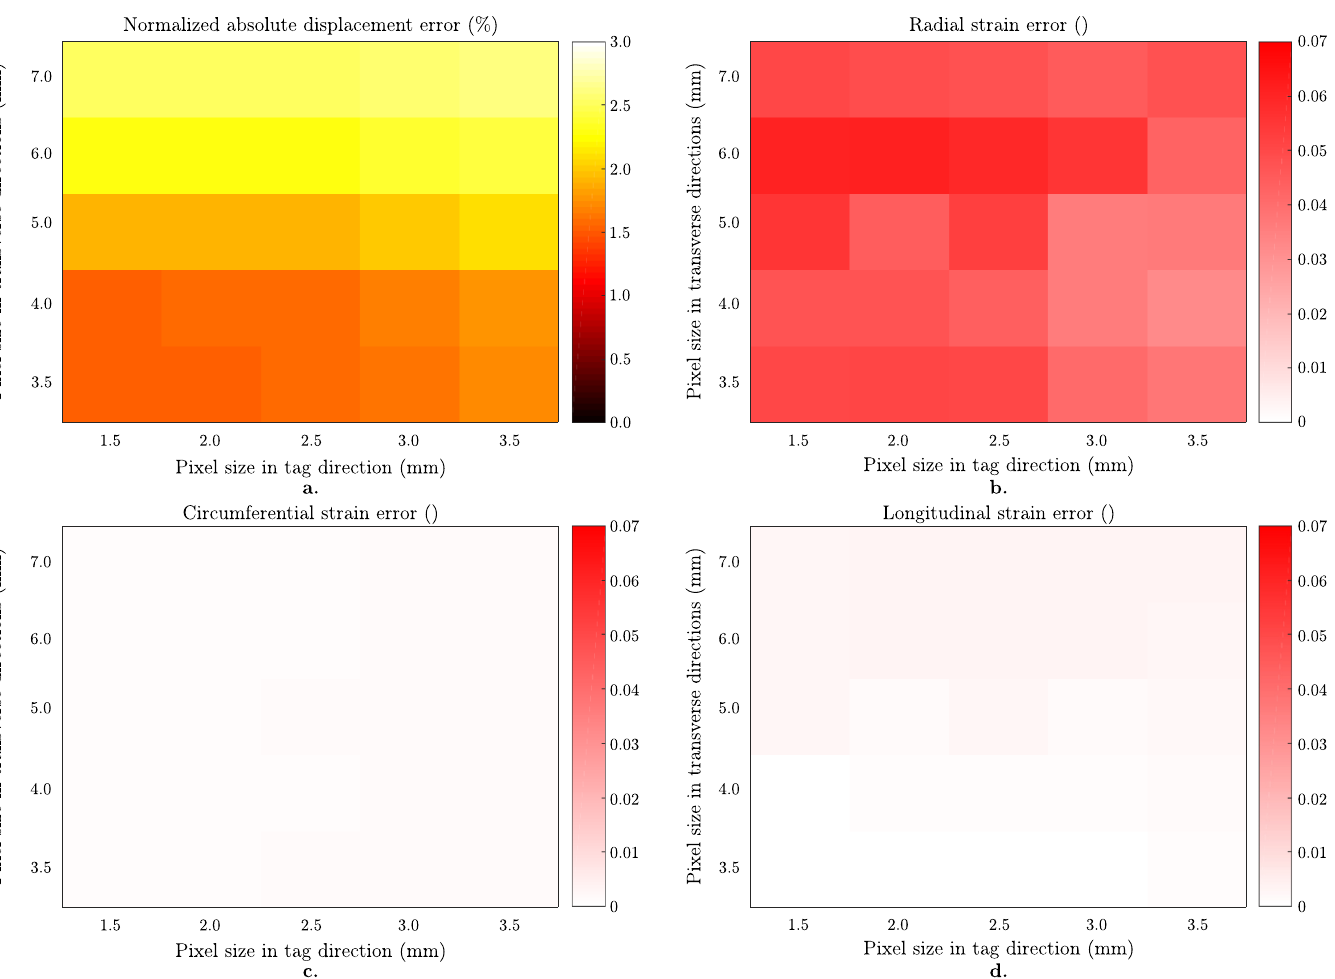
Fig 7. Effect of image resolution on anisotropically resolved image analysis. Results on noiseless images with 7 mm tag distance. Normalized mean ± standard deviations in displacement error norm (%) as a function of pixel size (a). Signed averages in Green-Lagrange strain component errors as a function of pixel size (b-d). Radial strain component is the most sensitive to an increase in pixel size (b), while circumferential (c) and the longitudinal (d) components are not affected at